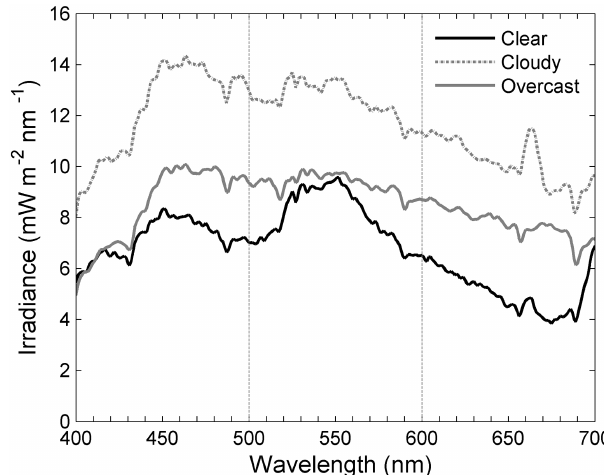
Figure 4. Spectral distribution of solar radiation at 5m above the ground for the wavelength range of PAR, showing the various dis- tributions of blue and in particular the fraction of blue wavelength (430–470) that does evoke stomatal opening (sensu Kuiper, 1964; Mansfield and Meidner,